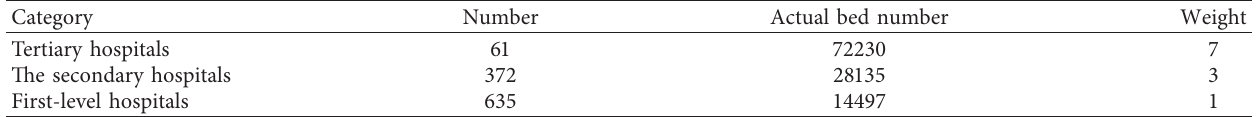
Table 1: Healthcare facility information.